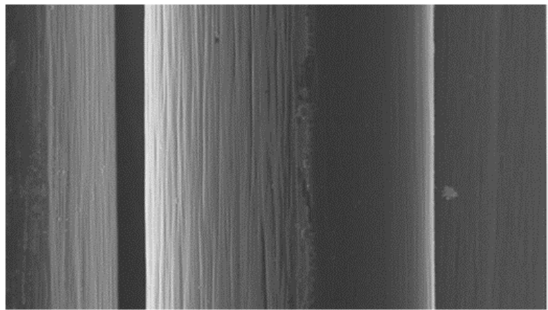
Figure 4. Image of a lot of sizing removed state by the hybrid method.